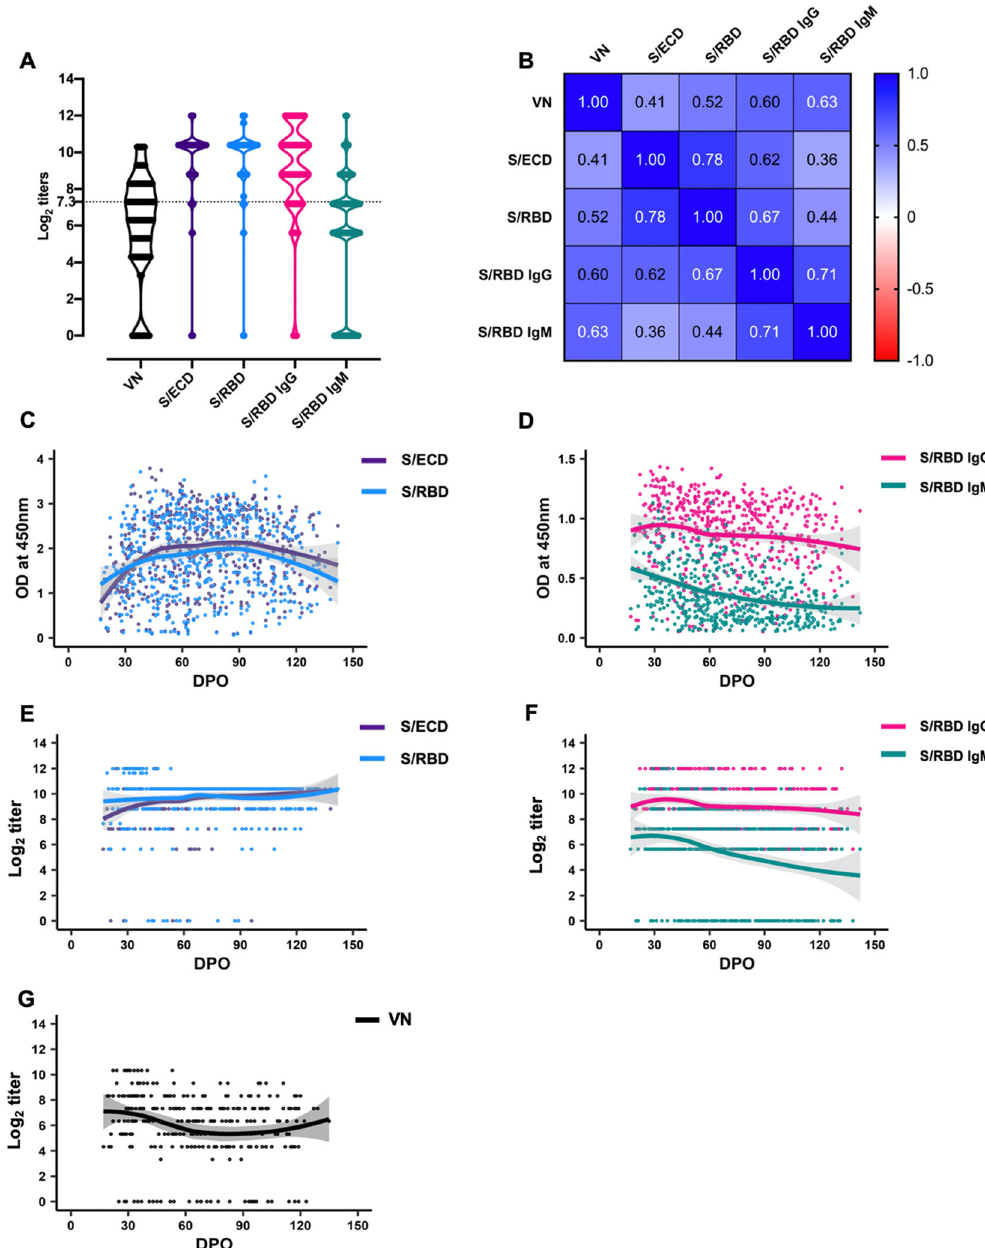
Fig. 1 Distribution, correlation, and trajectories of antibody titers against SARS-CoV-2. A Violin plots showing distribution of virus neutralization titers ( n = 305); total antibody ( n = 538), and speci fi c isotype antibody IgG and IgM ( n = 540) titers to SARS-CoV-2 spike-ectodomain (S/ECD) and spike- receptor binding domain (S/RBD) in convalescent plasma samples (log 2 transformed values). The means of the distribution among the titers were signi fi cantly different, except between S/ECD and S/RBD [One-way ANOVA, Tukey ’ s multiple comparison (mixed-effects model), P < 0.05]. The dashed line at log 2 titer represents VN titer of 1:160. B Pairwise comparison of the assays showed a moderate to strong correlation between the total and isotype- speci fi c IgG and IgM antibody estimates with virus neutralization assays. C , D Optical density (OD) (at 450 nm) for the indirect ELISAs indicating total or isotype-speci fi c IgG and IgM antibody levels. E , F Titers of the total or isotype-speci fi c IgG and IgM antibodies. The IgG and IgM titers peaked around 30 days post onset (DPO) of symptoms. High IgG titers persisted until 140 DPO, while IgM titers trended lower but persisted until 140 DPO. G Neutralizing antibody titers persisted until 140 DPO. A locally estimated scatterplot smoothing (LOESS) regression curve is fi tted to the data.